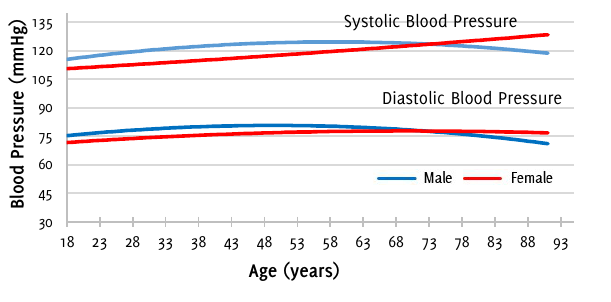
Comparing mean heart rate from all three BP readings, a similar phenomenon from that observed with BMI emerges, where the greater the heart rate, the higher the increase in BP. An increase of 16.68 mmHg in SBP and 10.79 mmHg in DBP were seen with heart rates ≥ 100